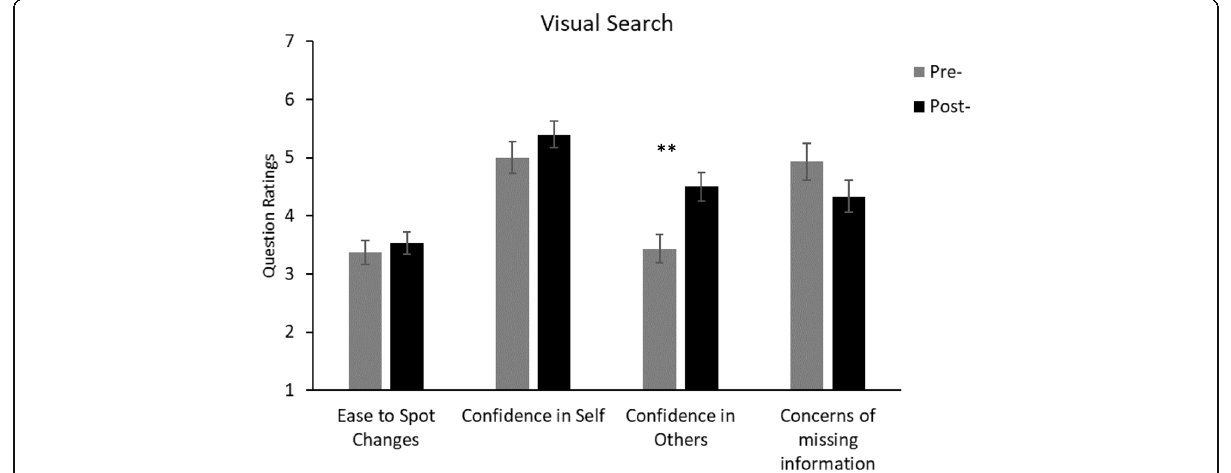
Fig. 5 Average ratings from the post-demonstration data of the visual search condition in Experiment 2. The pre-questionnaire data were taken from the replication condition for statistical comparison. For the “ ease to spot changes ” question, the rating scale ranged from 1 (very difficult) to 5 (very easy). For the other questions, the rating scales ranged from 1 (not at all confident/concerned) to 7 (totally confident/concerned). Significant difference: ** p < 0.01. Error bars represent the standard error. See Additional file 1 for the full